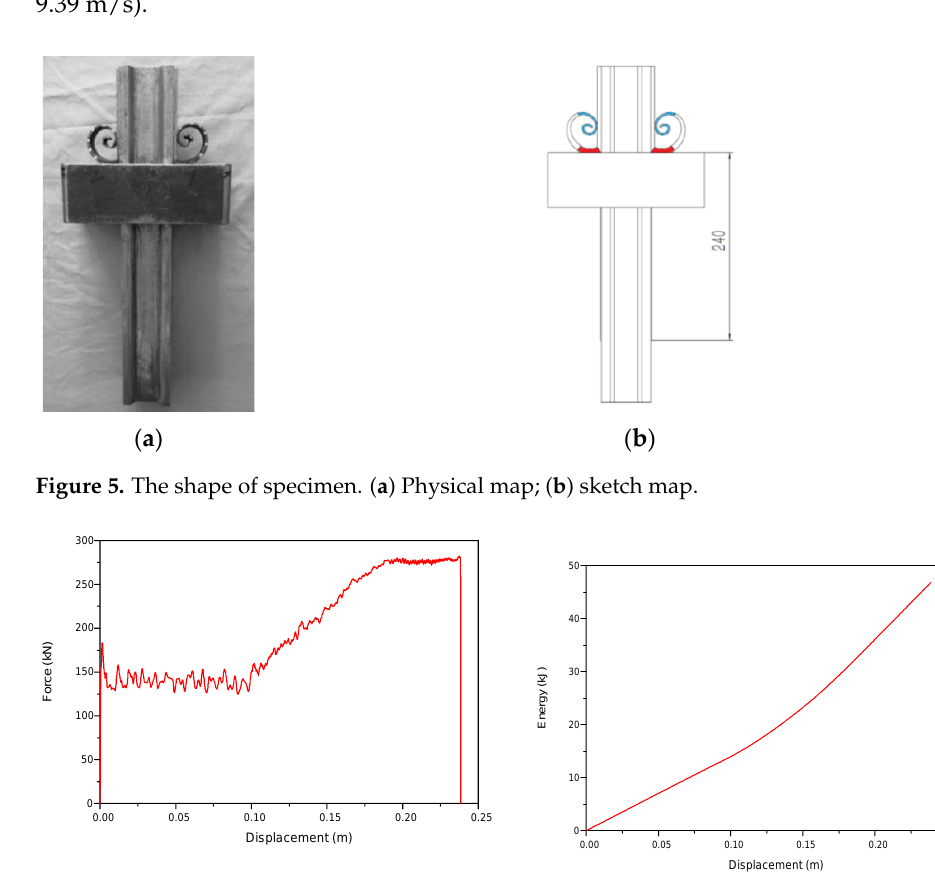
Figure 6. Force-displacement and energy-displacement curves. ( a ) Cushioning force-stroke curve; ( b ) energy-stroke curve.